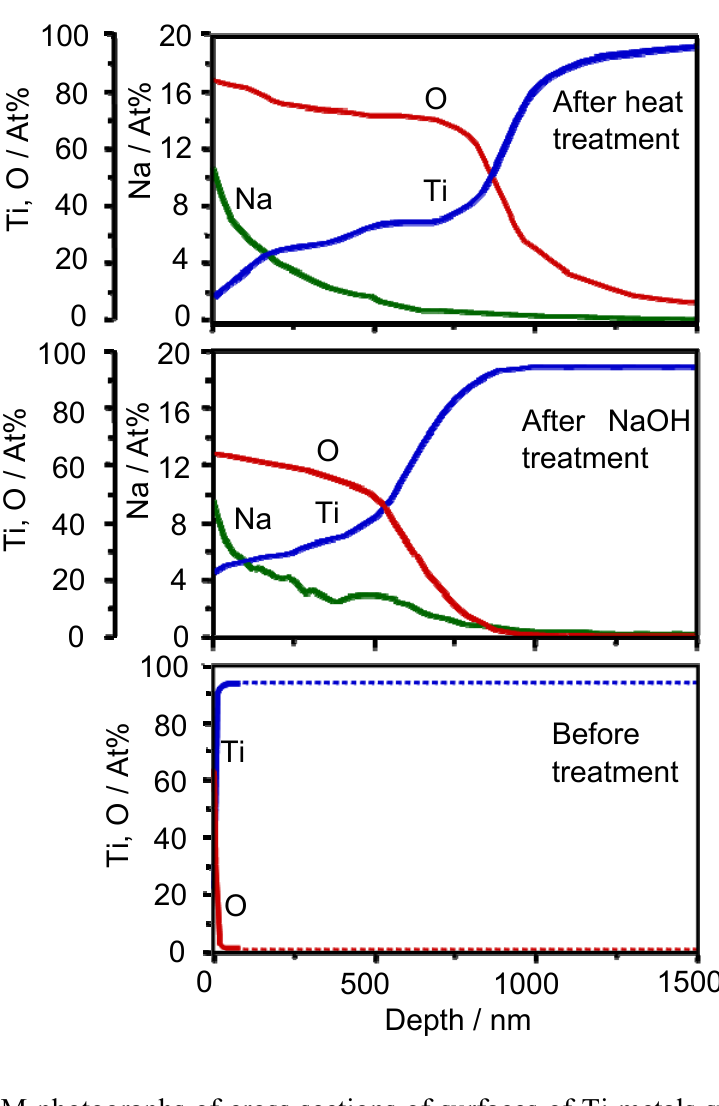
Figure 1. AES depth profiles of the surfaces of Ti metals untreated and those subjected to NaOH and heat treatments.